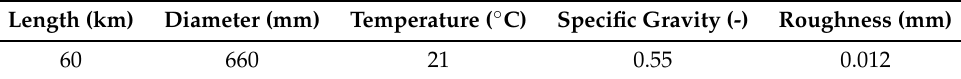
Figure 3. A gas pipe with step variation for inlet pressure. Table 1. The basic parameters of the pipeline used in Example I.